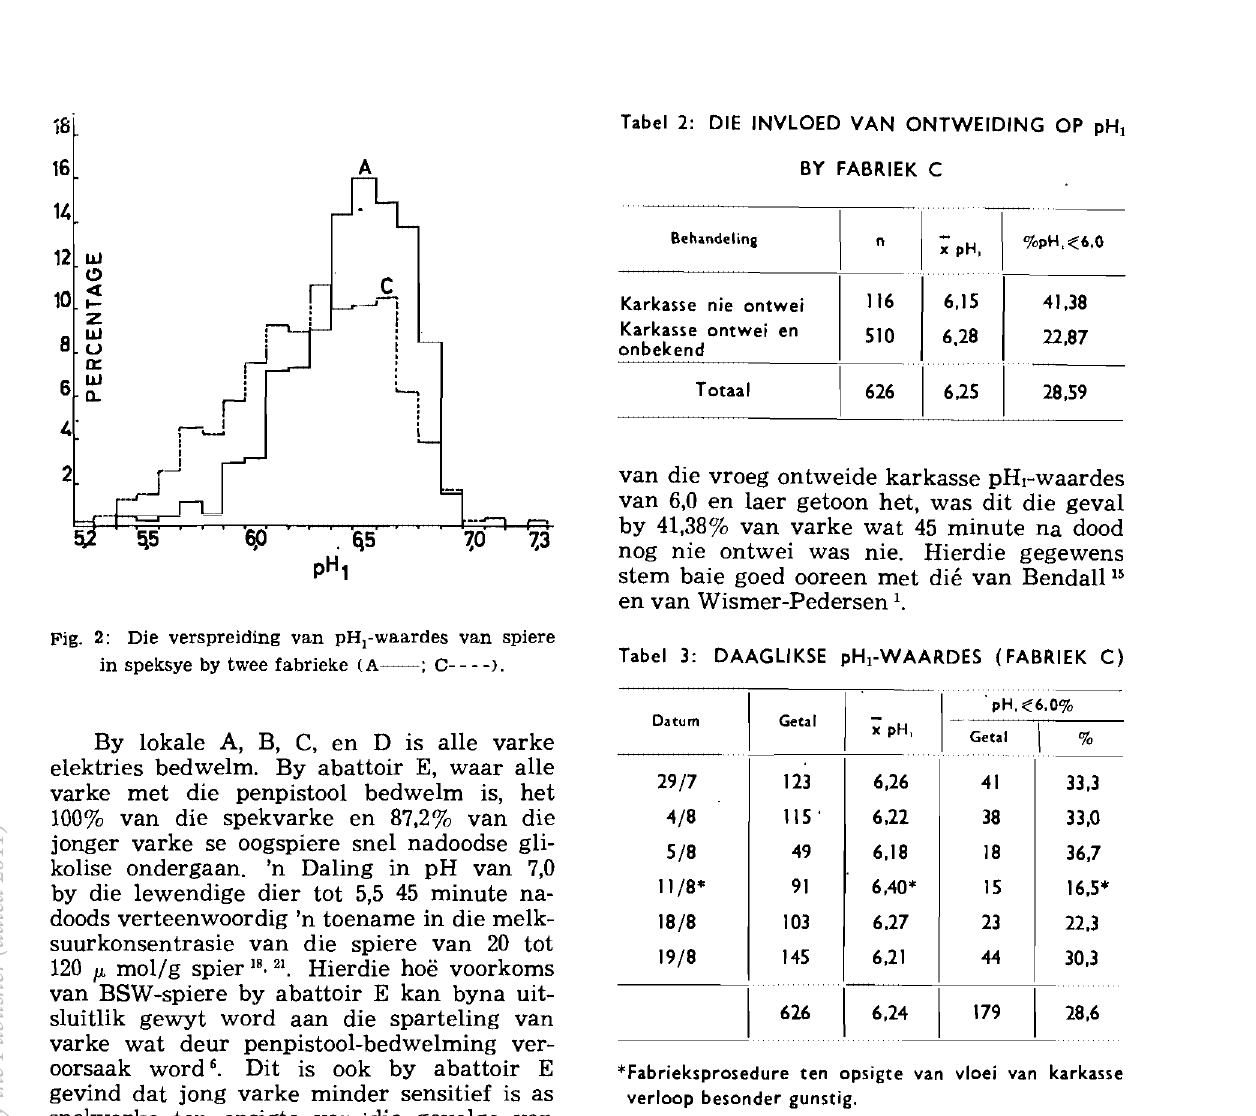
Tabel 2: DIE INVLOED VAN ONTWEIDING OP pHI